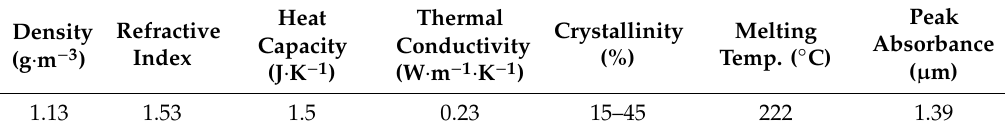
Table 1. Relevant properties of Polyamide 6 for laser welding (optical properties for natural version) [6].